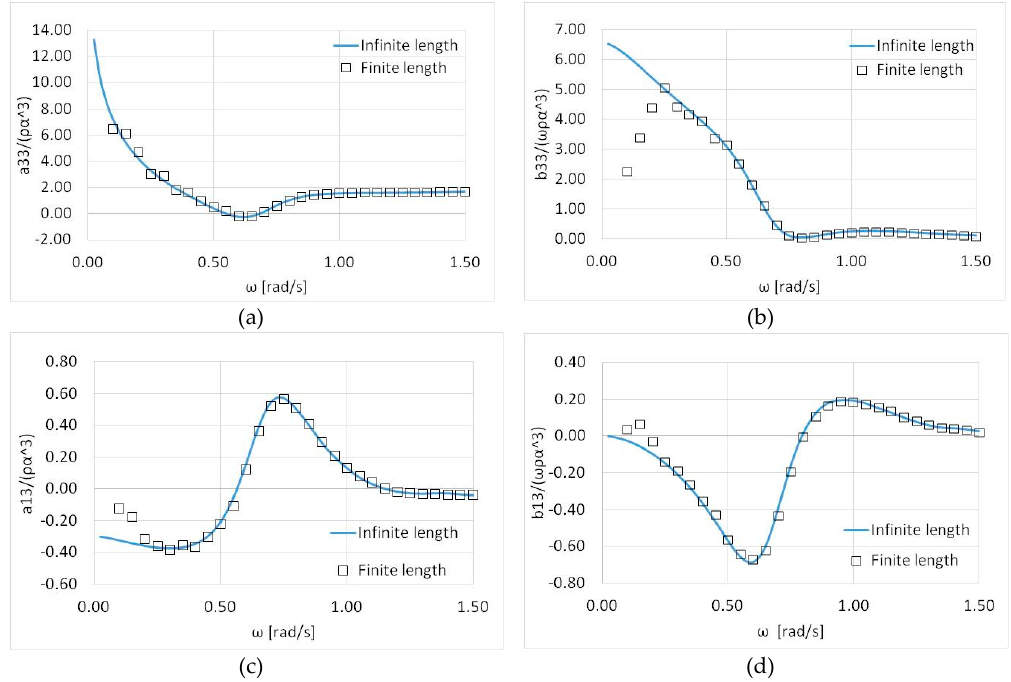
Figure 14. Hydrodynamic coe ffi cients of a floating cylindrical floater placed in front of an orthogonal breakwater of finite length: ( a ) heave added mass due to motion of the floater in heave ( b ) heave damping coe ffi cient due to motion of the floater in heave ( c ) surge-added mass due to motion of the floater in heave ( d ) surge damping coe ffi cient due to motion of the floater in heave. The results are compared with the corresponding values of the same floater placed in front of an infinite length orthogonal